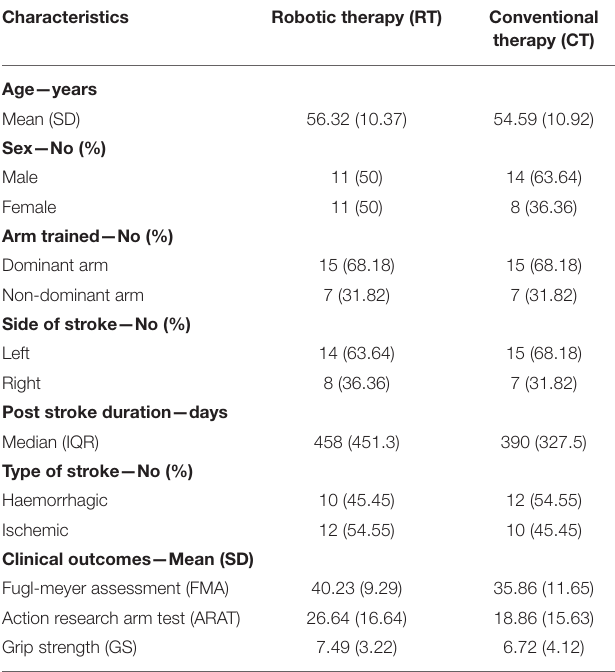
TABLE 1 | Baseline demographic and clinical characteristics by training groups.